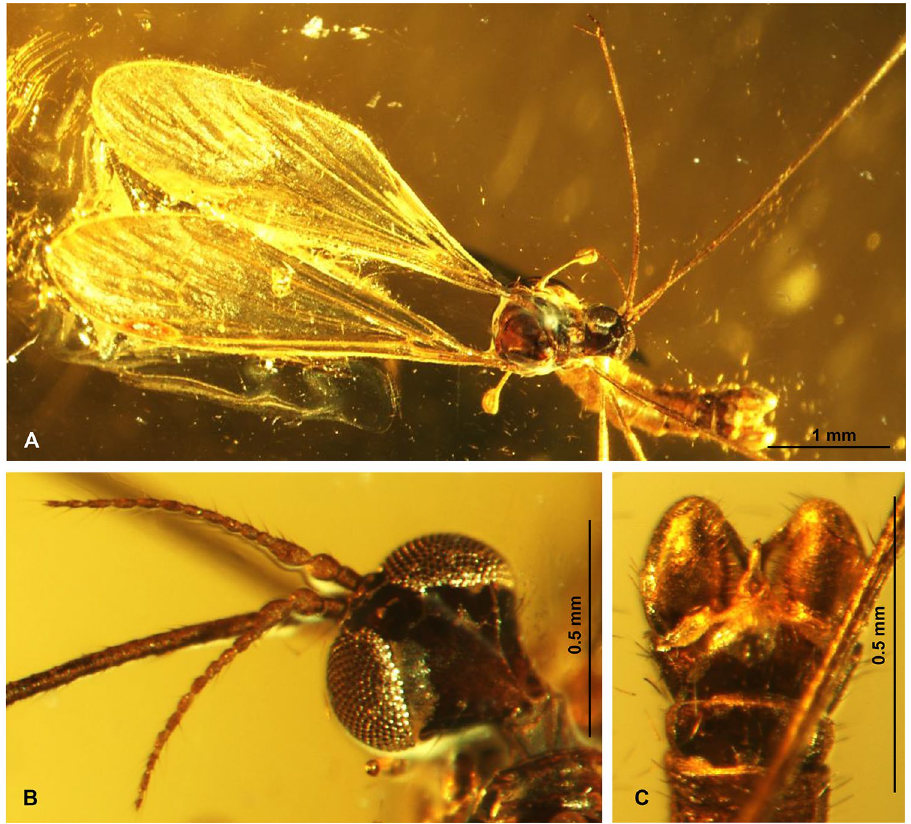
Figure 3. Elephantomyia (s. str.) christelae sp. nov. No. CCHH 874–2 (male), coll. Ch. & H. W. Hoffeins, holotype, photographs: ( A ) the body (dorso-ventral view); ( B ) enlarged view of antenna; ( C )